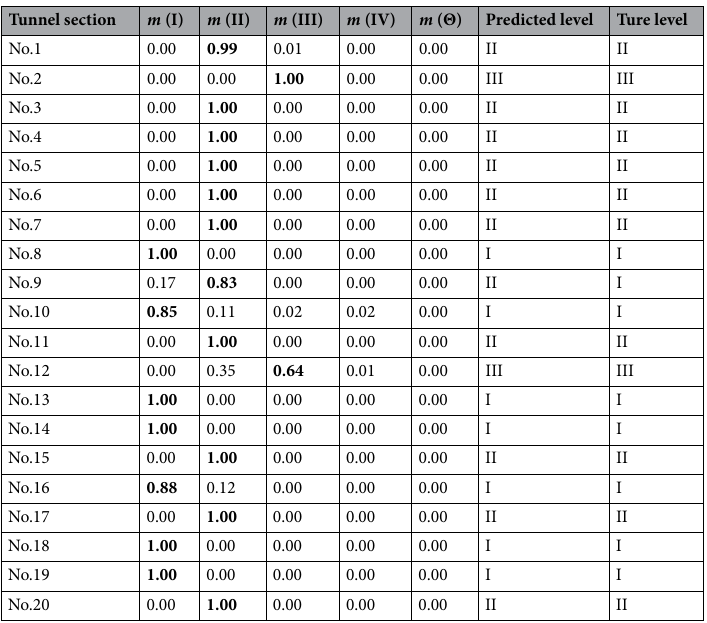
Table 8. Results of multi-source information fusion at ten monitoring sections. Significant values are in bold.